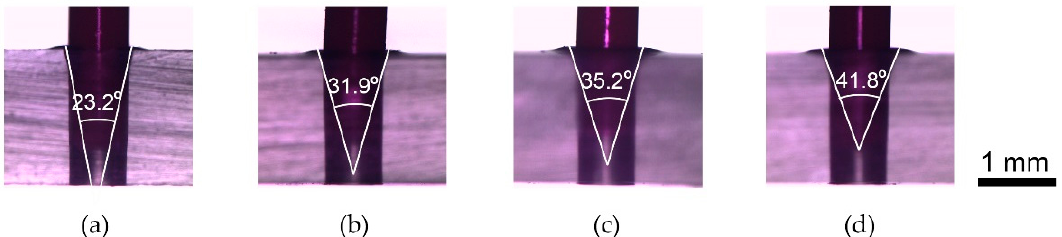
Figure 5. The side-view of capillary inserted in microhole. ( a ) for 23.2 ° ( b ) for 31.9 ° ( c ) for 35.2 ° ( d ) for 41.8 ° .